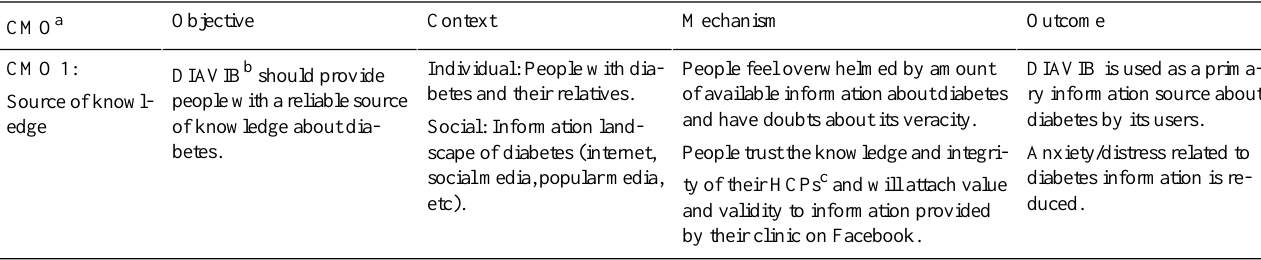
Table 2. Context-mechanism-outcome configuration 1: Diabetes Viborg as source of knowledge about diabetes. OutcomeMechanismContextObjectiveCMO a